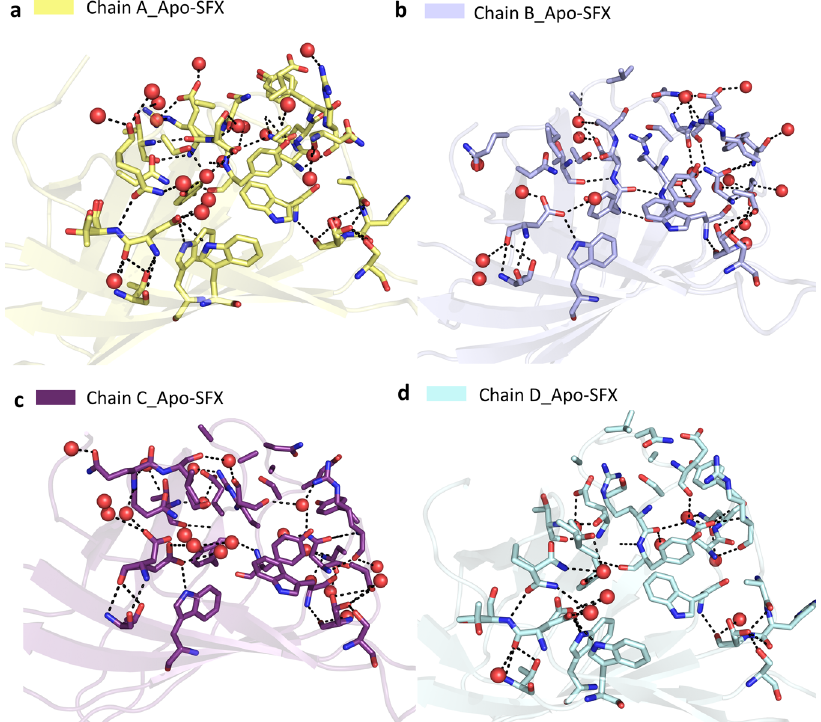
Fig. 5 Representation of coordinated water molecules and polar interactions near the binding sites for each chain of Apo-SFX structure. Coordinated water molecules within the binding pocket were altered and polar interactions were reduced with loop opening in Apo-SFX structure. All polar interactions were observed within 3.6 Å. a Binding site residues of chain A were observed with 19 water molecules and 51 polar interactions. Those interactions provide the stability of the chain, which was similar to the selenobiotin-bounded structure. b Chain B-binding site residues were determined with 19 water molecules and 46 polar interactions that were involved. c Residues of the binding site of chain C have 40 polar interactions between residues and 20 water molecules. d Chain D-binding site residues involve 9 water molecules and 31 polar interactions. All interactions included H-bonds and electrostatic interactions and are presented with dashed lines. Water molecules are indicated with red-colored